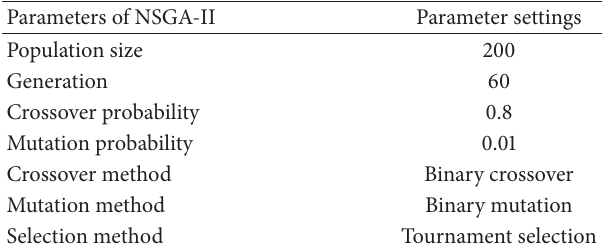
Table 2: Parameters of NSGA-II for feature